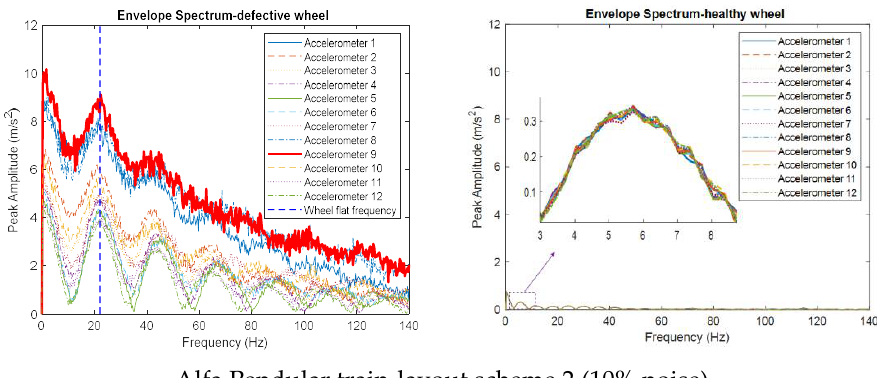
Figure 13. Envelope spectrum analysis for the 12 accelerometers (layout scheme 2) with different noise intensities and considering a defective and healthy wheel of the Alfa Pendular train and the freight wagon.